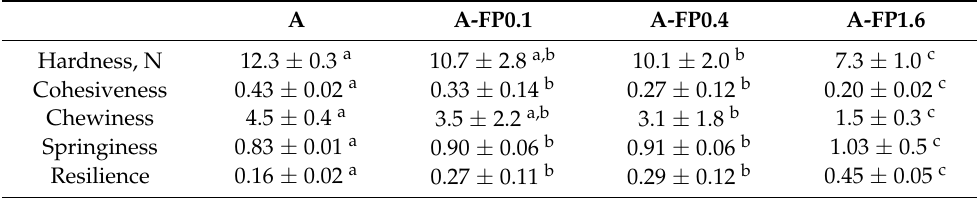
Figure 1. Appearance of A ( A ), A-FP0.1 ( B ), A-FP0.4 ( C ), and A-FP1.6 ( D ) gels. The mechanical behavior of A and A-FP gels was first monitored in the puncture test, and all gels demonstrated force–distance curves with one peak (Figure 2A). Hardness, determined as a peak force through the puncture of A-FP0.1, A-FP0.4, and A-FP1.6 gels was 9, 14, and 44% lower than that of A gel, respectively (Table 1). The consistency of A-FP0.1, A-FP0.4, and A-FP1.6 gel was 13, 16, and 37% lower than that of A gel, respectively. The texture profile analysis (TPA) results are presented in Figure 2B and Table 2. FP decreased the hardness of A gel. The hardness of A-FP1.6 gel was 41% lower than A gel. Similar data was obtained for cohesiveness and chewiness. The cohesiveness of A-FP0.1, A- FP0.4, and A-FP1.6 gel was 1.3, 1.6, and 2.2 times lower than that of A gel, respectively. The chewiness of A-FP0.4 and A-FP1.6 gels was 1.5 and 3 times lower, respectively, than that of springiness and resilience of A-FP1.6 gel was 1.2 and 2.8-fold of A gel sample, respectively. Table 2. The texture profile analysis (TPA) properties of A and A-FP enriched